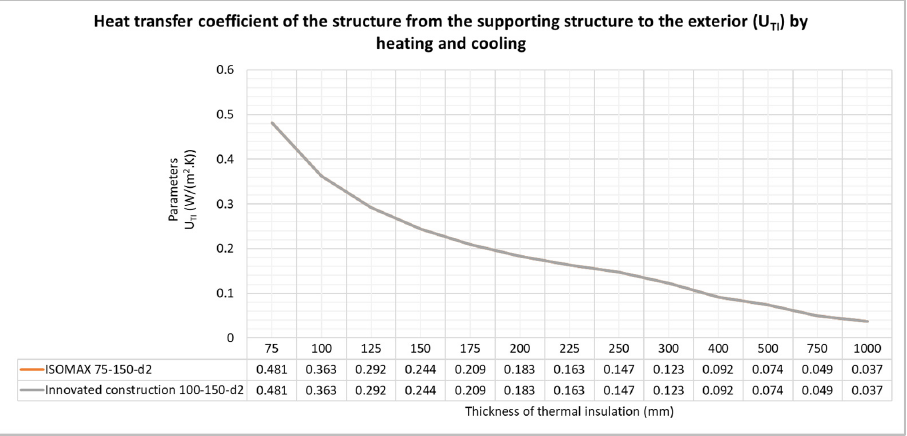
Figure 22. Dependence of the heat transfer coefficient U TI of the exterior thermal insulation on the thickness.